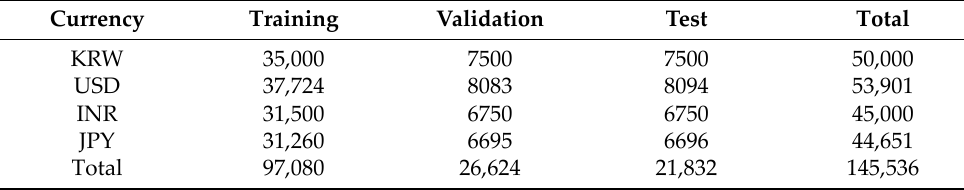
Table 1. Size of dataset for each currency.